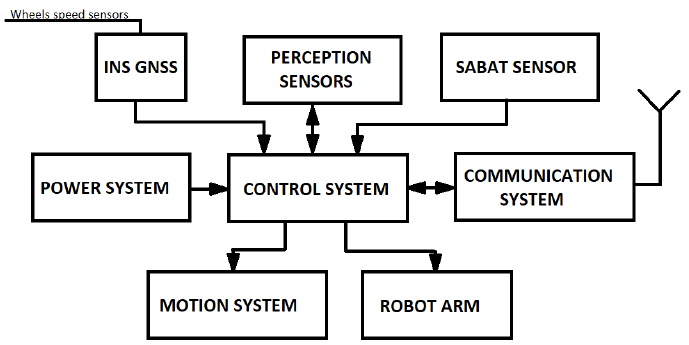
Figure 3. System architecture of the UGV which will be used to carry the neutron-based sensor.